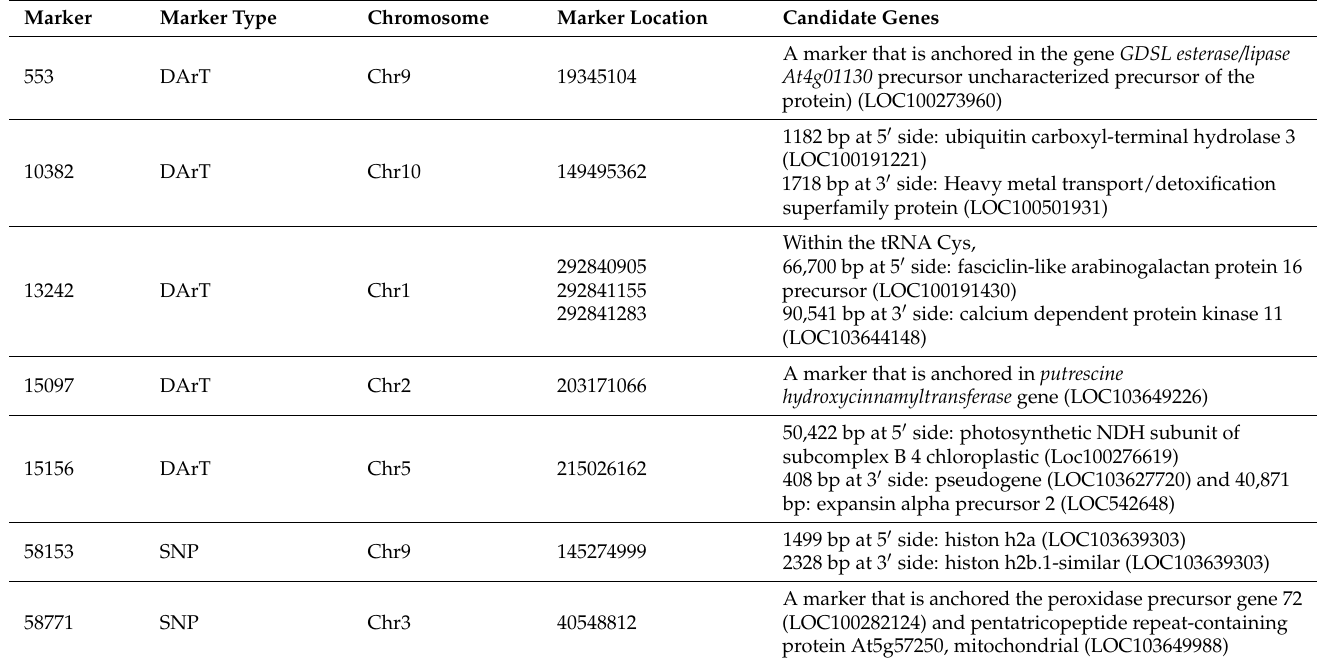
Table 4. Characteristics and location of markers significantly related to plant resistance to fusarium.